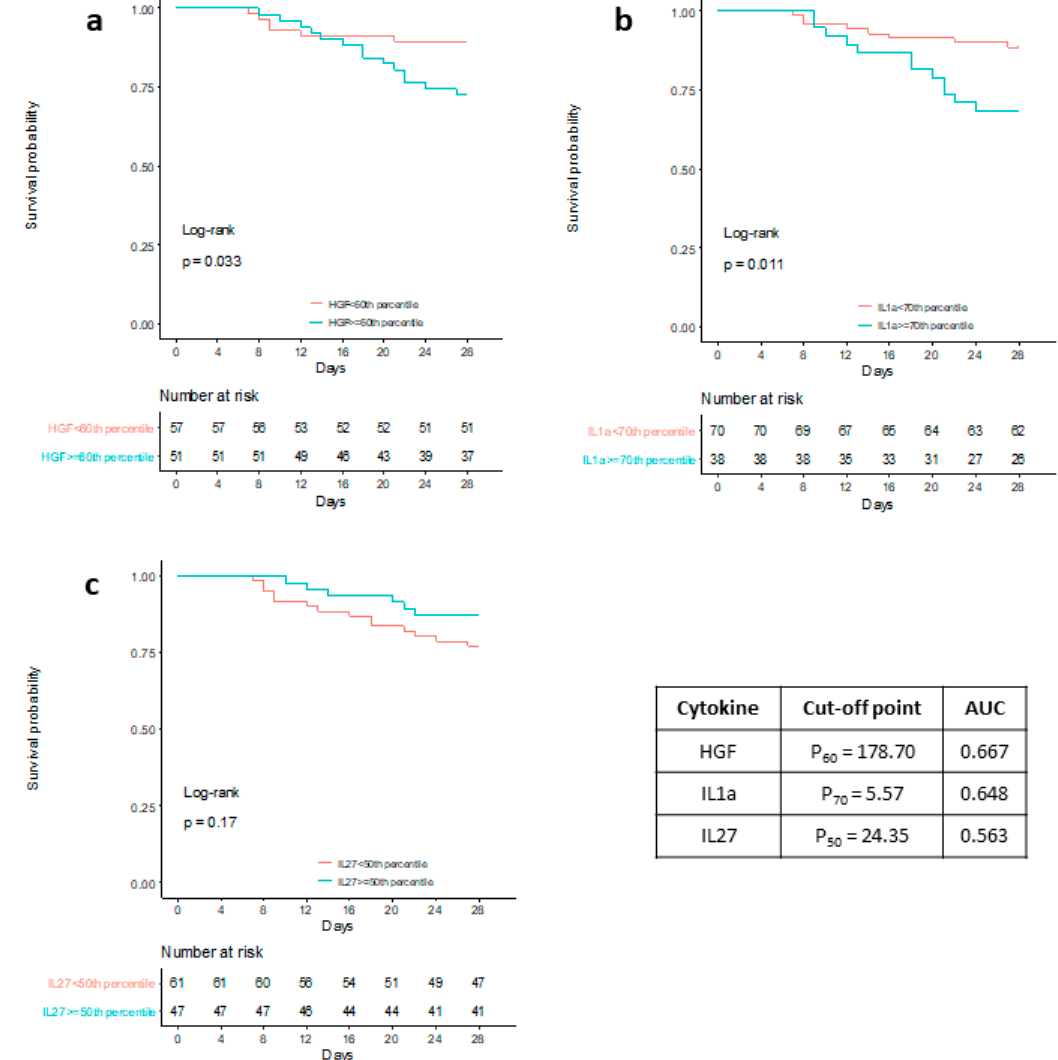
Figure 3. Kaplan–Meier survival curves for HGF ( a ), IL-1 α ( b ), IL-27 ( c ). Figure 3. Kaplan-Meier survival curves for HGF ( a ), IL-1 α ( b ), IL-27 ( c